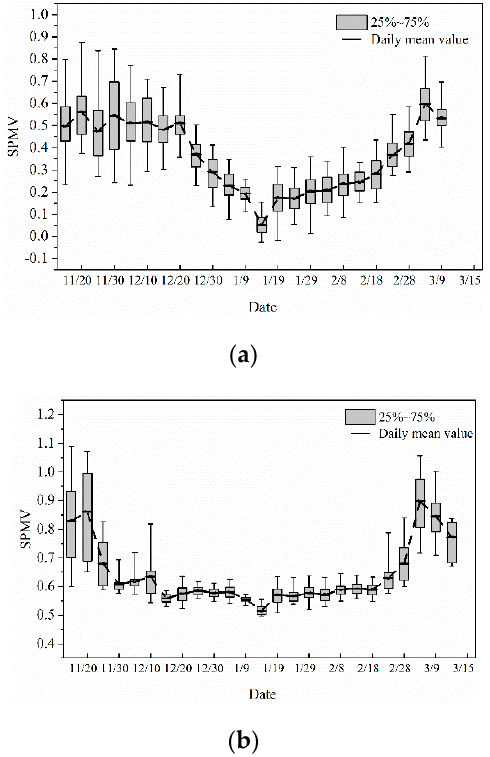
Figure 4. SPMV in the heating season for south-facing bedrooms: ( a ) original building and ( b ) standard building.